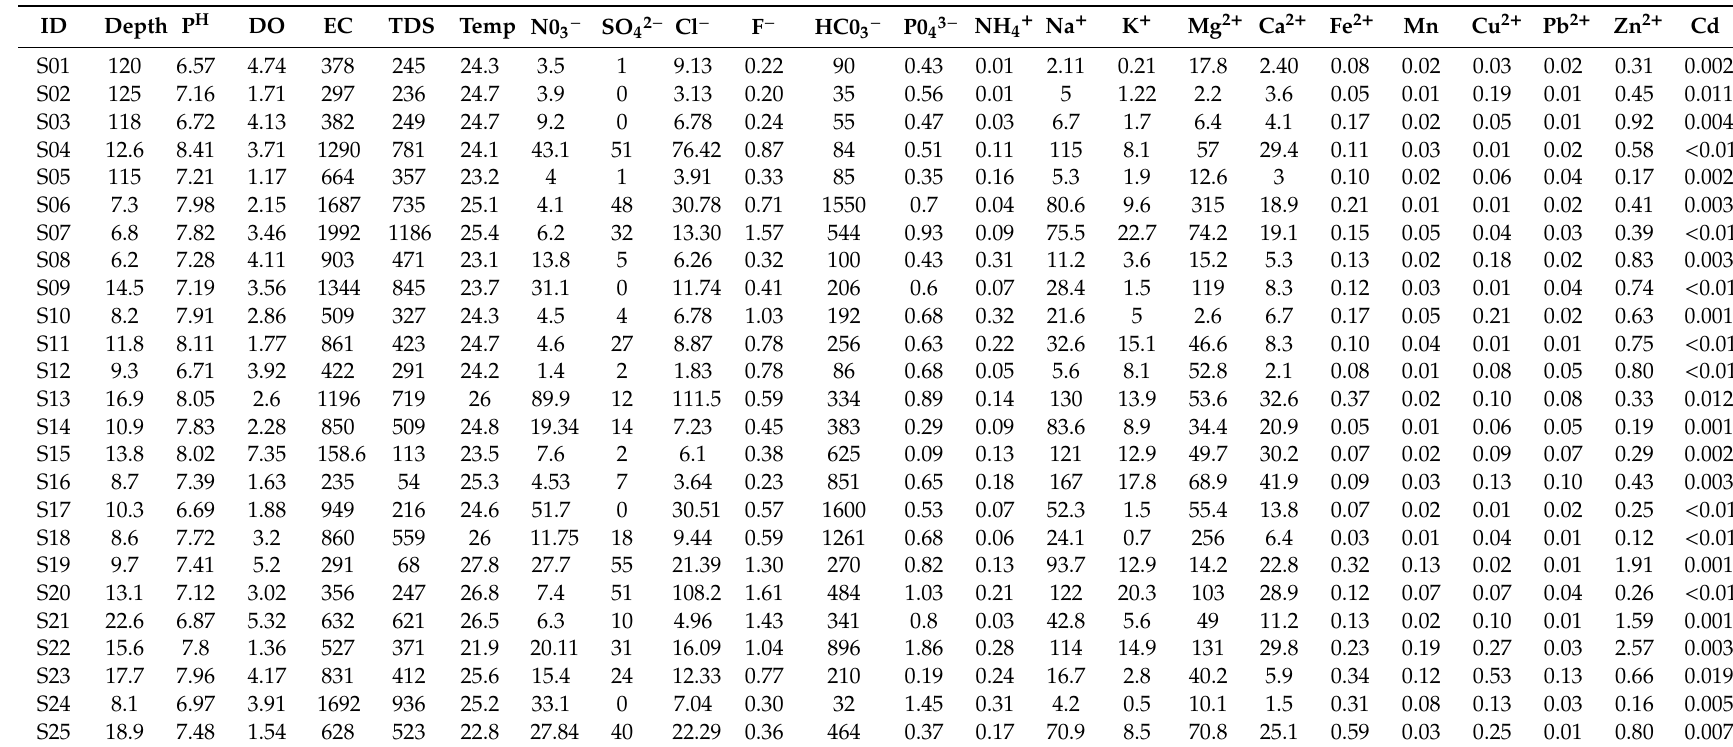
Table A1. Water quality parameter of groundwater for the wet